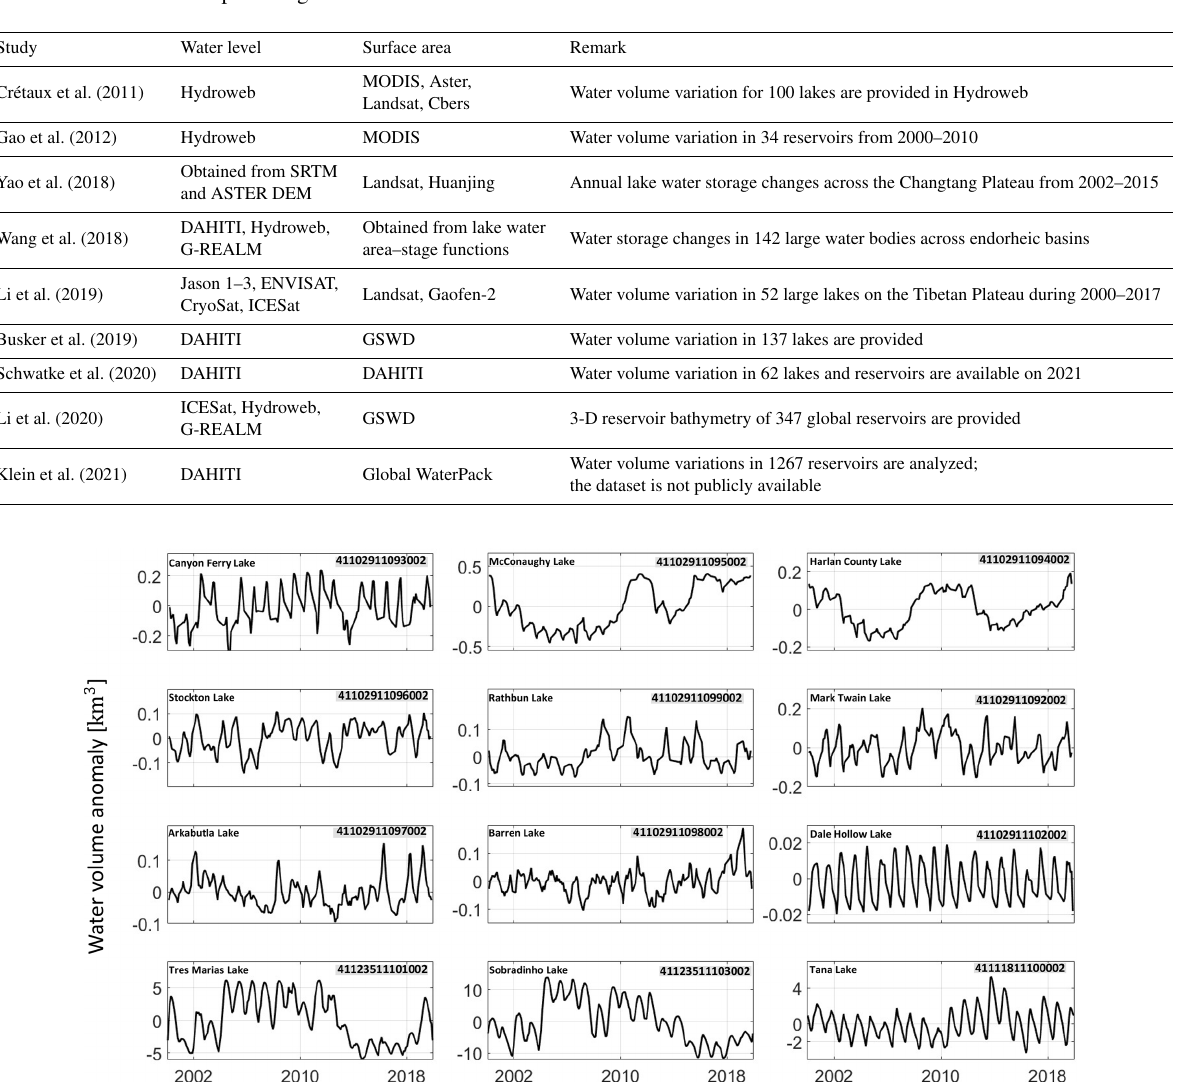
Table 4. Overview of studies providing time series of lake and reservoir water volume variations.